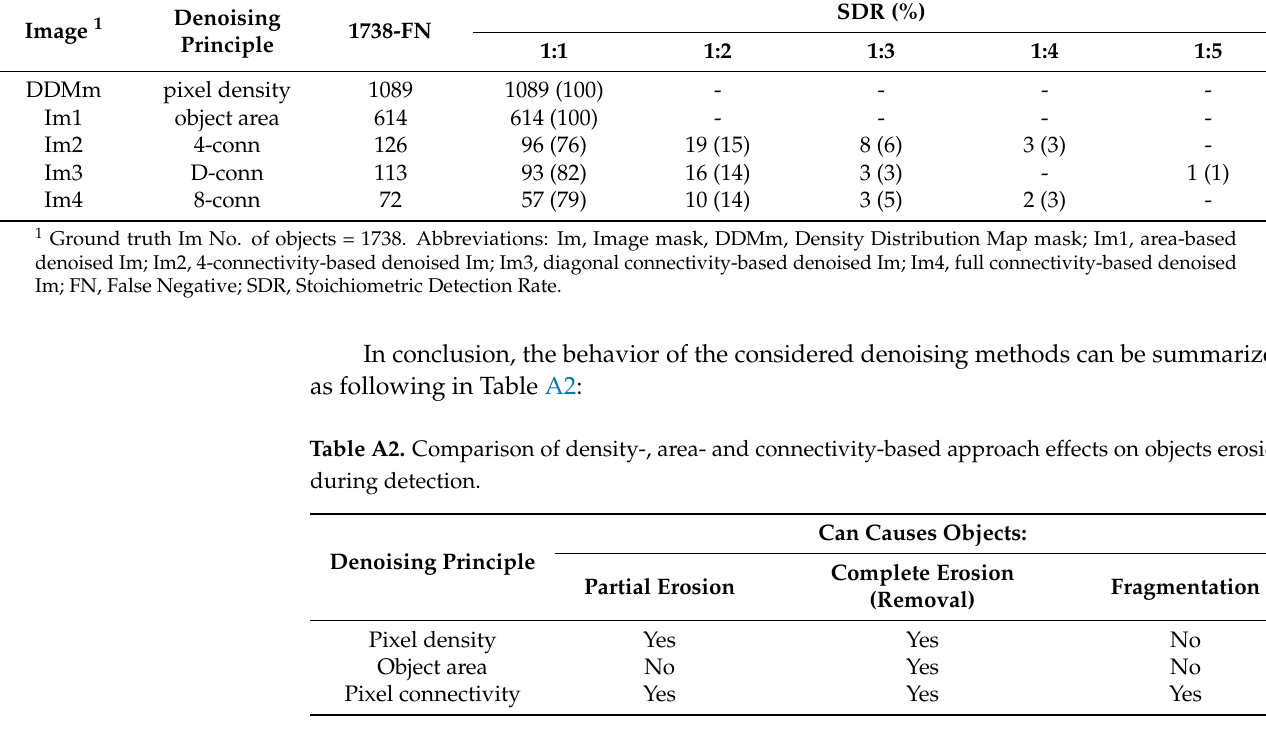
Table A1. Stoichiometric detection rate for object counting with density-, area- and connectivity-based approach. Denoising Image 1